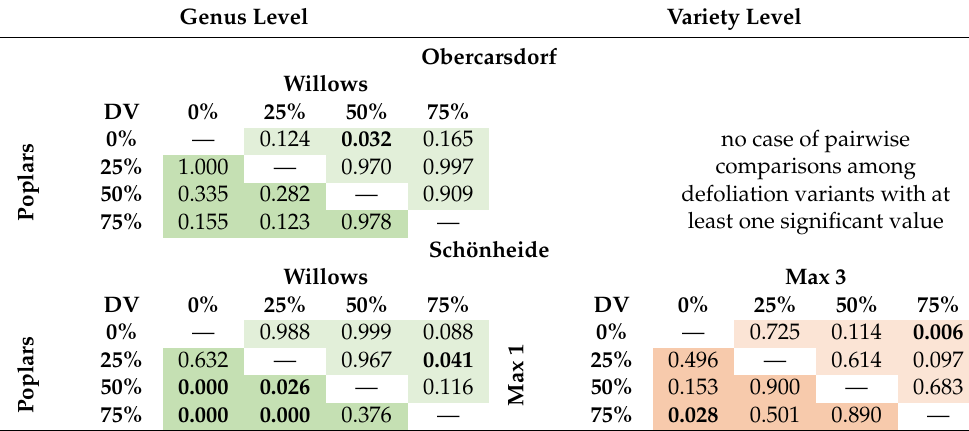
comparisons among defoliation variants with